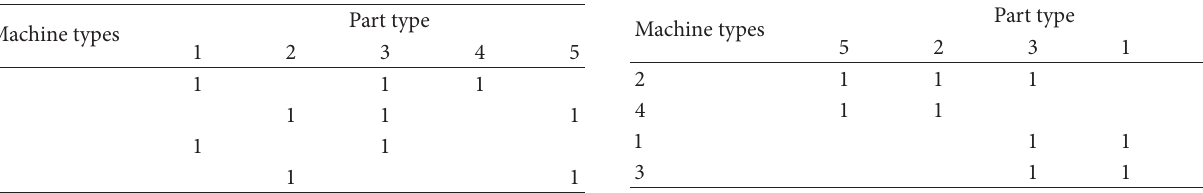
Table 1: Machine-part matrix. Table 2: Solution matrix of cell